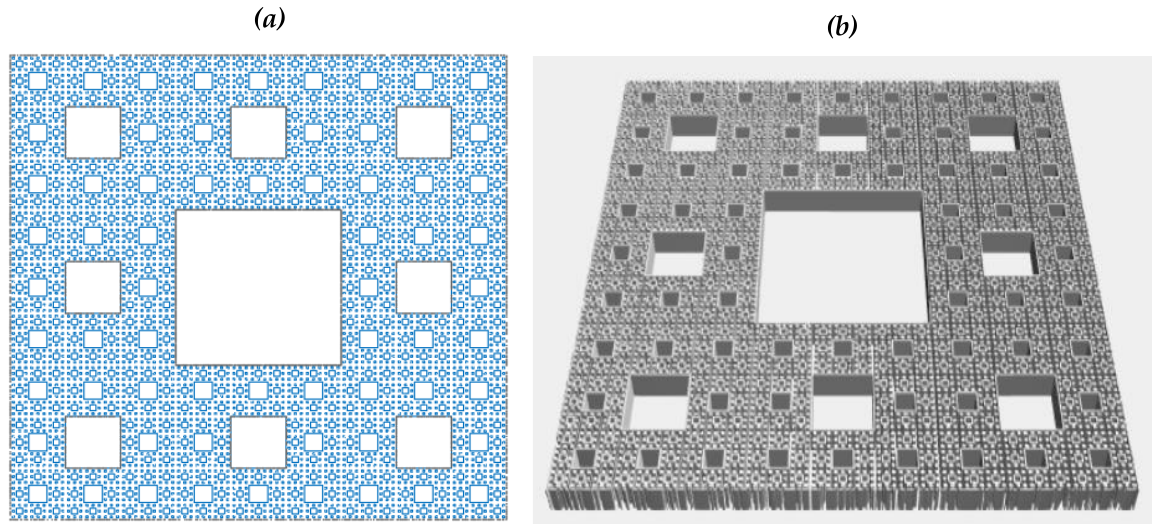
Figure 11. Point clouds controlled up to the fifth level and its solid CAD model: ( a ) the point clouds; ( b ) the solid CAD model.